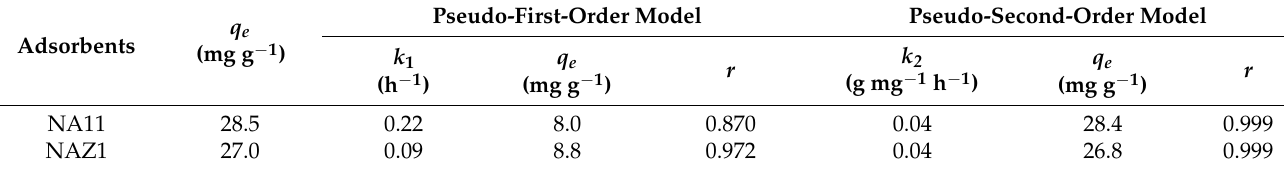
Figure 2. Effect of contact time on the adsorption of Cr(VI) using NA11 and NAZ1. Table 2. Kinetic parameters for the adsorption of